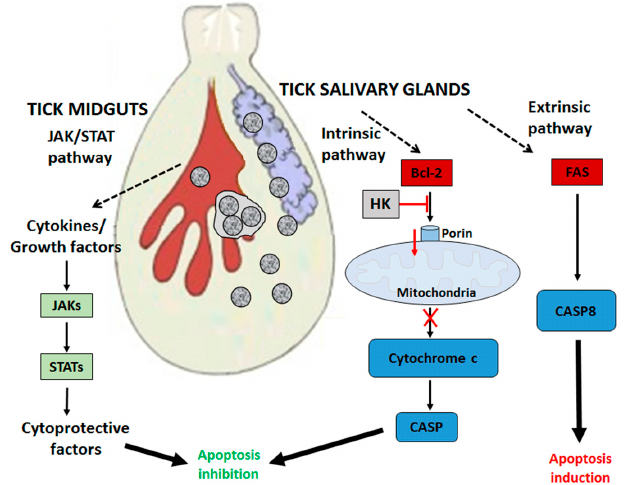
Figure 2. Effect of A. phagocytophilum infection on apoptosis pathways in ticks. Tissue-specific differences in response to infection are evident. In tick midguts, A. phagocytophilum inhibits apoptosis through up-regulation of the JAK/STAT pathway. In tick salivary glands, down-regulation of porin results in the inhibition of the cytochrome c release, inhibiting the mitochondrially-induced intrinsic apoptosis pathway. This effect is balanced in part by the induction of the extrinsic apoptosis pathway through the inhibition of fatty acid synthase (FAS) proteins. Up-regulated in green , down-regulated in red . CASP: caspase; HK: hexokinase.